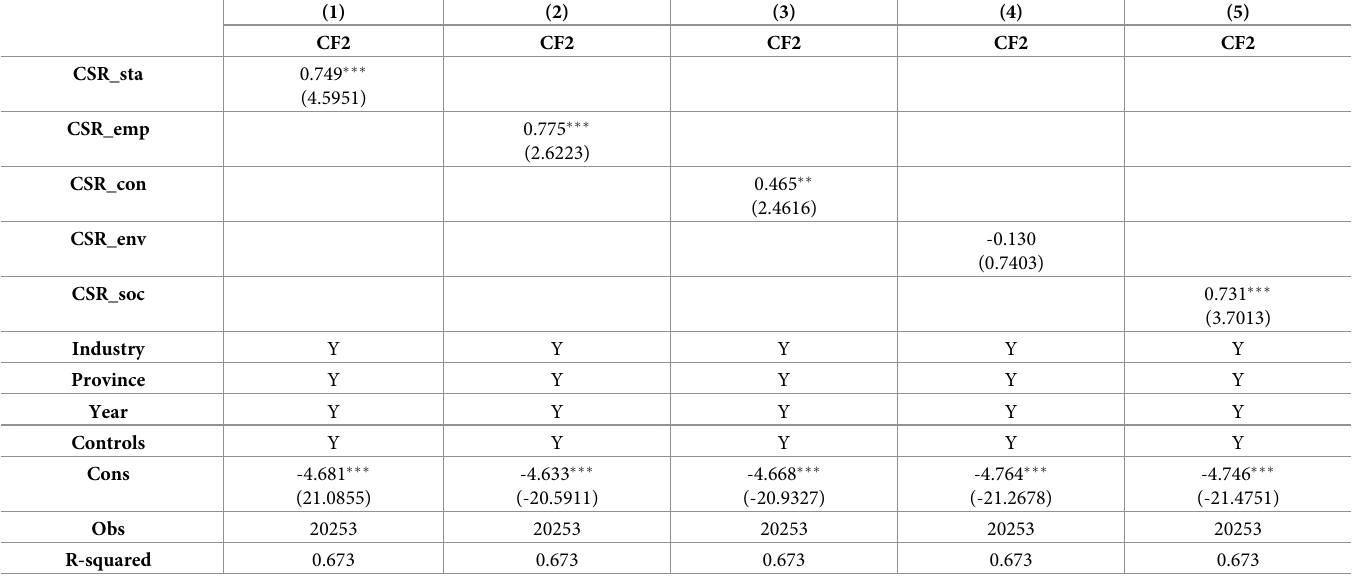
Table 7. Sensitivity test: Score test for each sub-item of